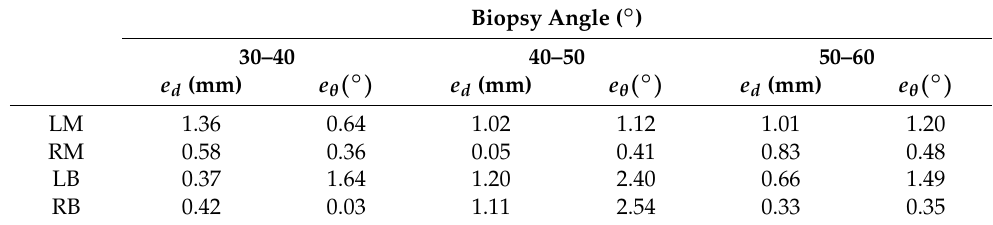
Table 4. Results of the blueberry biopsy experiments.